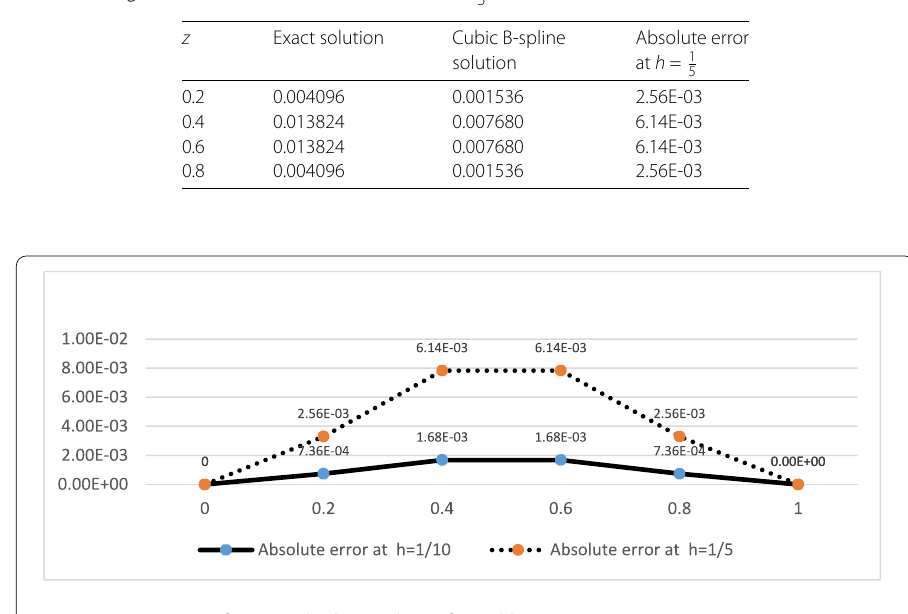
Table 11 Algebraic outcomes for Problem 3 at h = 1